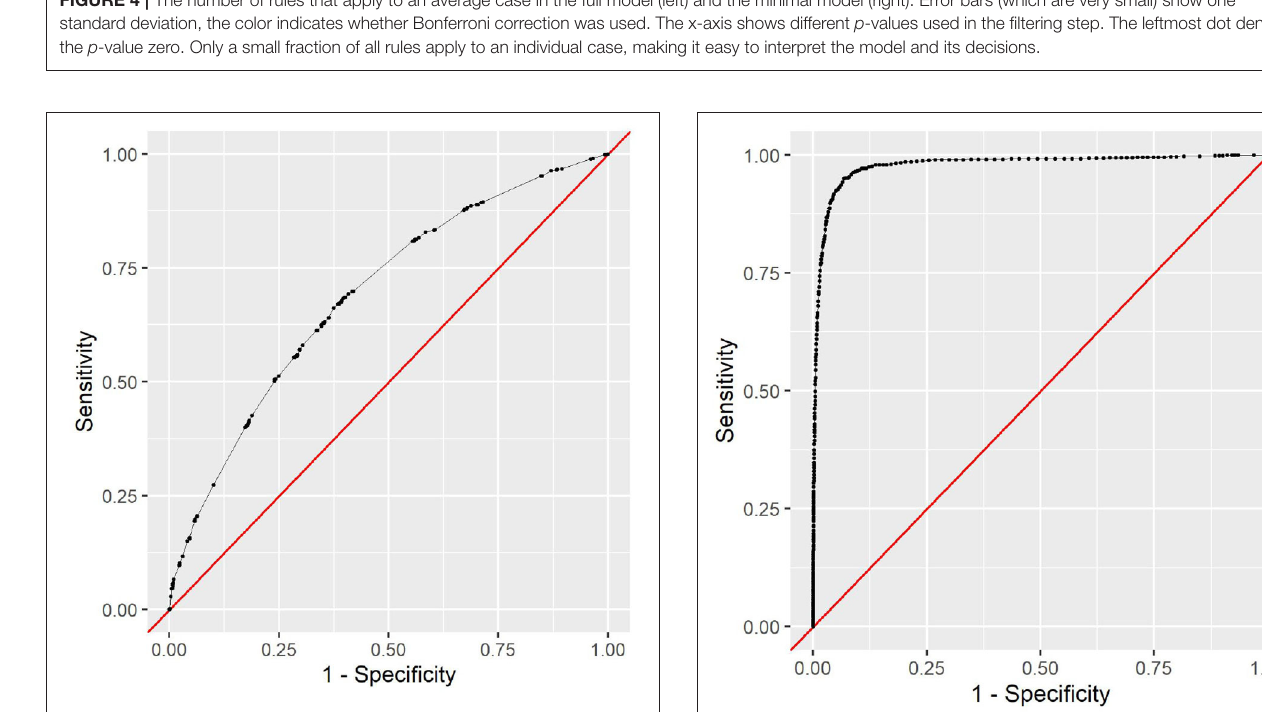
pressure ulcers (5.29–17.96), sepsis and septicemia (4.15–33.18), and diabetes (1.56–13.20). Some doubling occurs due to